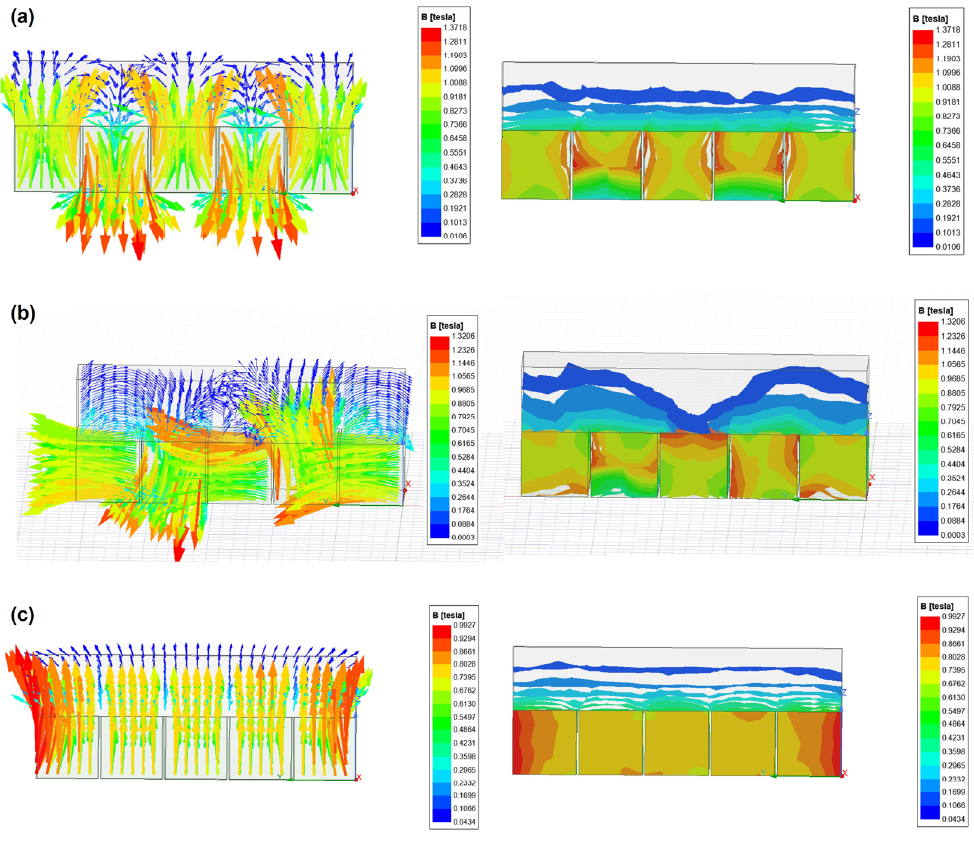
Figure 8. Magnet configuration to create linear and discontinuous patterns, using ( a ) alternated polarity, ( b ) Halbach array, and ( c ) same polarity configurations.